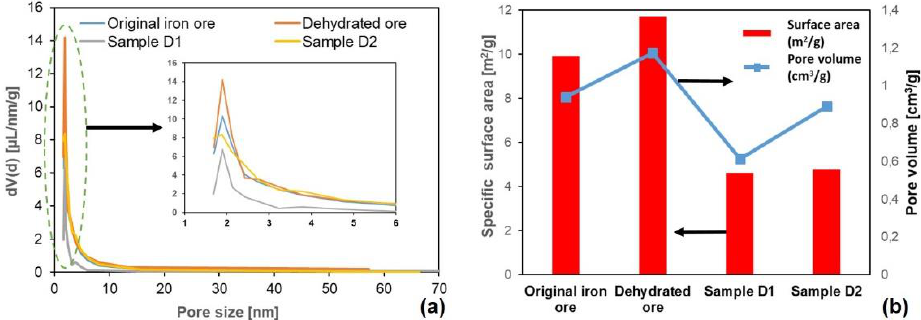
Figure 3. Changes in ( a ) pore size distribution; ( b ) S BET and V BJH values of original iron ore, dehydrated ore, and D1 and D2 samples. (S BET : Brunauer, Emmett and Teller (BET) Specific Surface Area; V BJH : Barrett-Joyner-Halenda (BJH) pore volume).